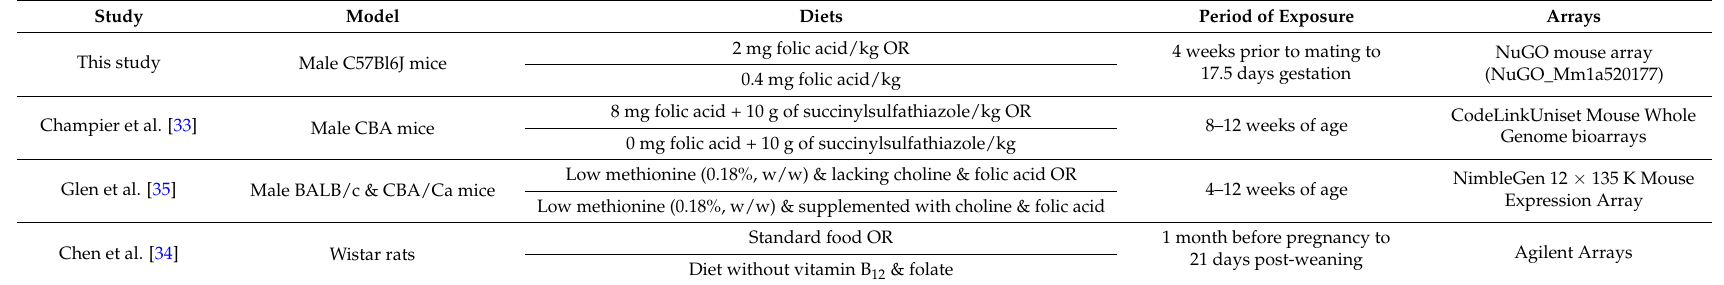
Table 10. Overview of experimental designs of studies investigating the influence of folate/methyl donor intake on genome wide gene expression in the